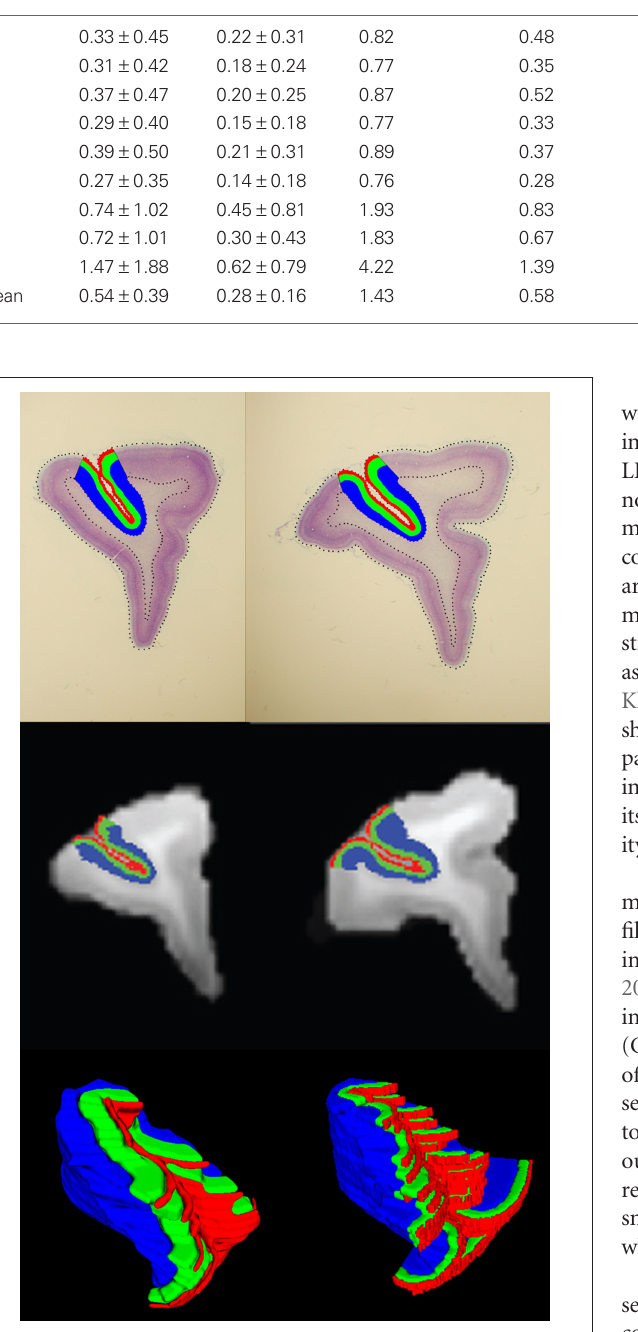
FIguRe 6 | Area 46 layers (red: layer I, green: layers II–III–IV, blue: layers V–VI) on histological sections (top row) and the same layers on the MRI slices (middle row) after registration. Example 3D surfaces for area 46 layers in the MRI space (bottom